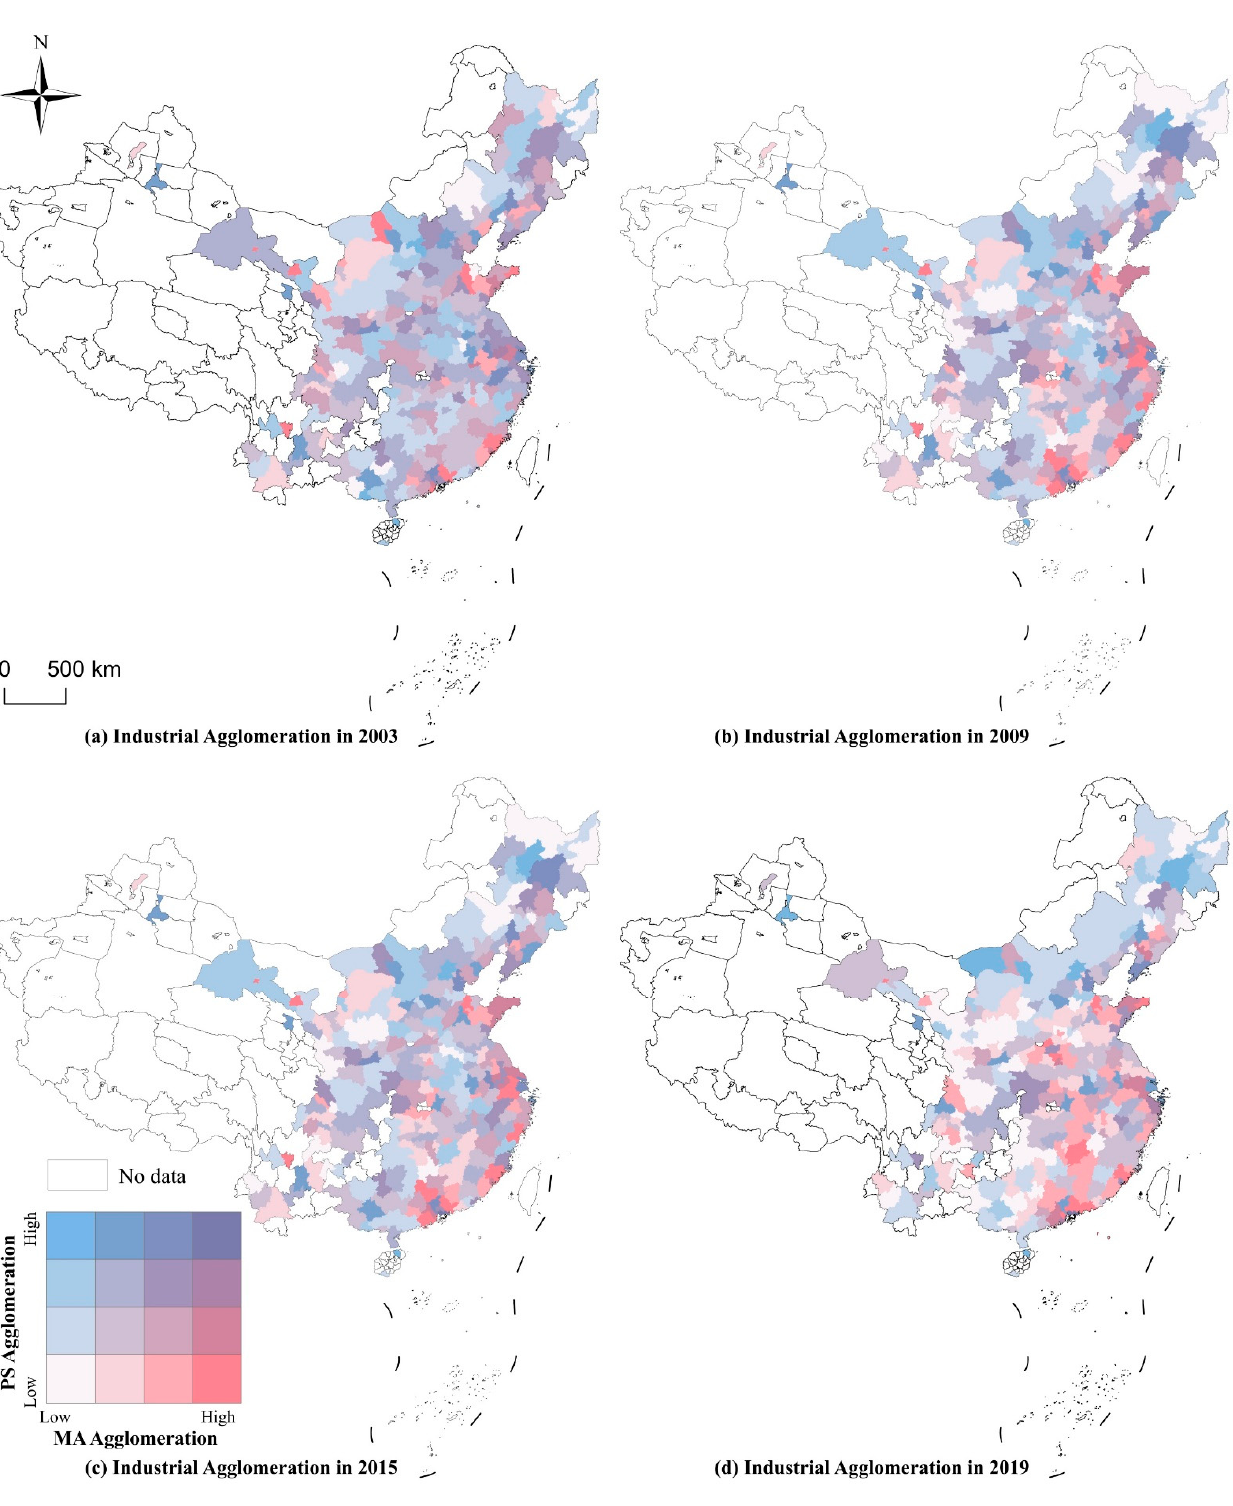
Figure 4. Result for industrial agglomeration in 283 cities in China from 2003 to 2019. ( a ) Result for industrial agglomeration in 2003. ( b ) Result for industrial agglomeration in 2009. ( c ) Result for industrial agglomeration in 2015. ( d ) Result for industrial agglomeration in 2019.